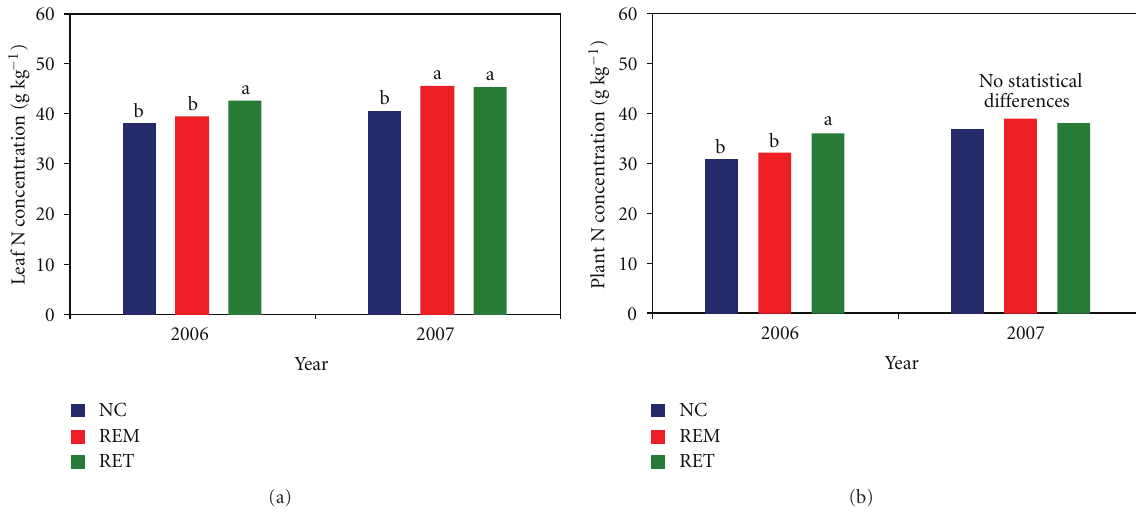
Figure 1: E ff ect of rye residue management and year on (a) leaf N concentration and (b) plant N concentration, at first square. Columns sharing the same letter for each parameter inside of year are not significantly di ff erent ( P ≤ 0 . 05). NC: no winter cover crop; REM: rye residue removed; RET: rye residue